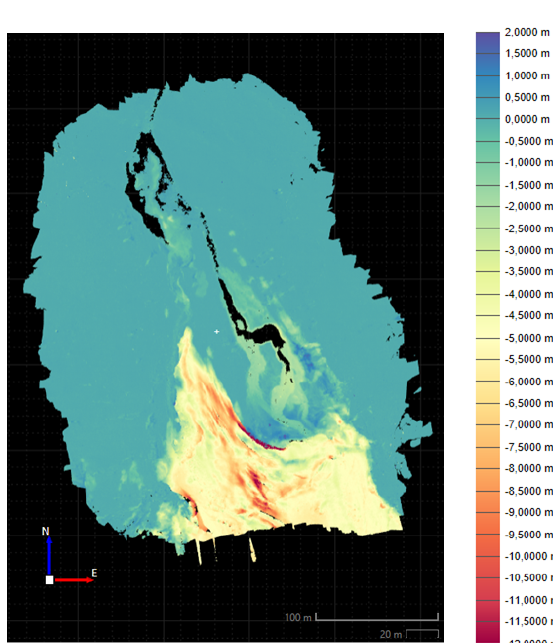
Figure 10. Height comparison map between the 2020 and 2021 DPCs - UAV track post-processing and direct